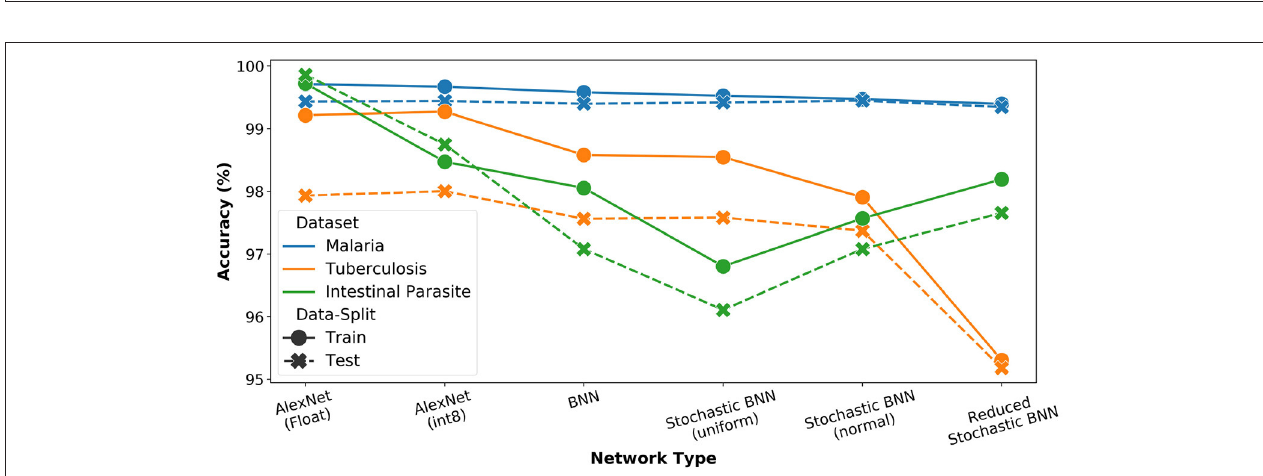
Frontiers in Neuroscience |